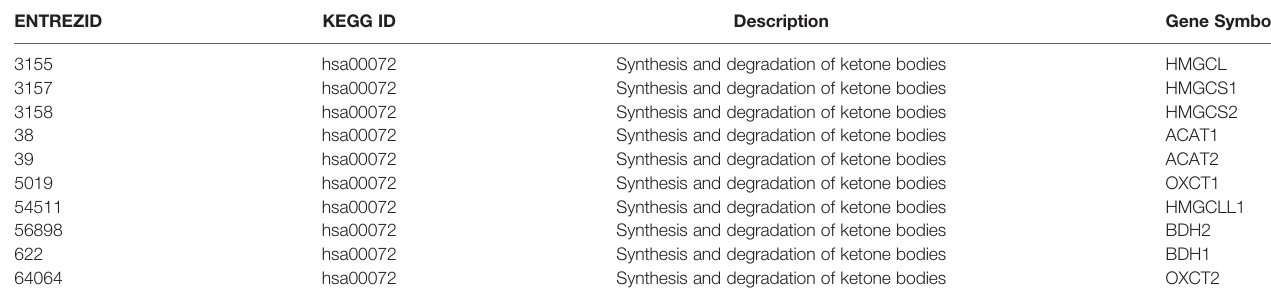
TABLE 1 | Gene list of “ Synthesis and degradation of ketone bodies ” .